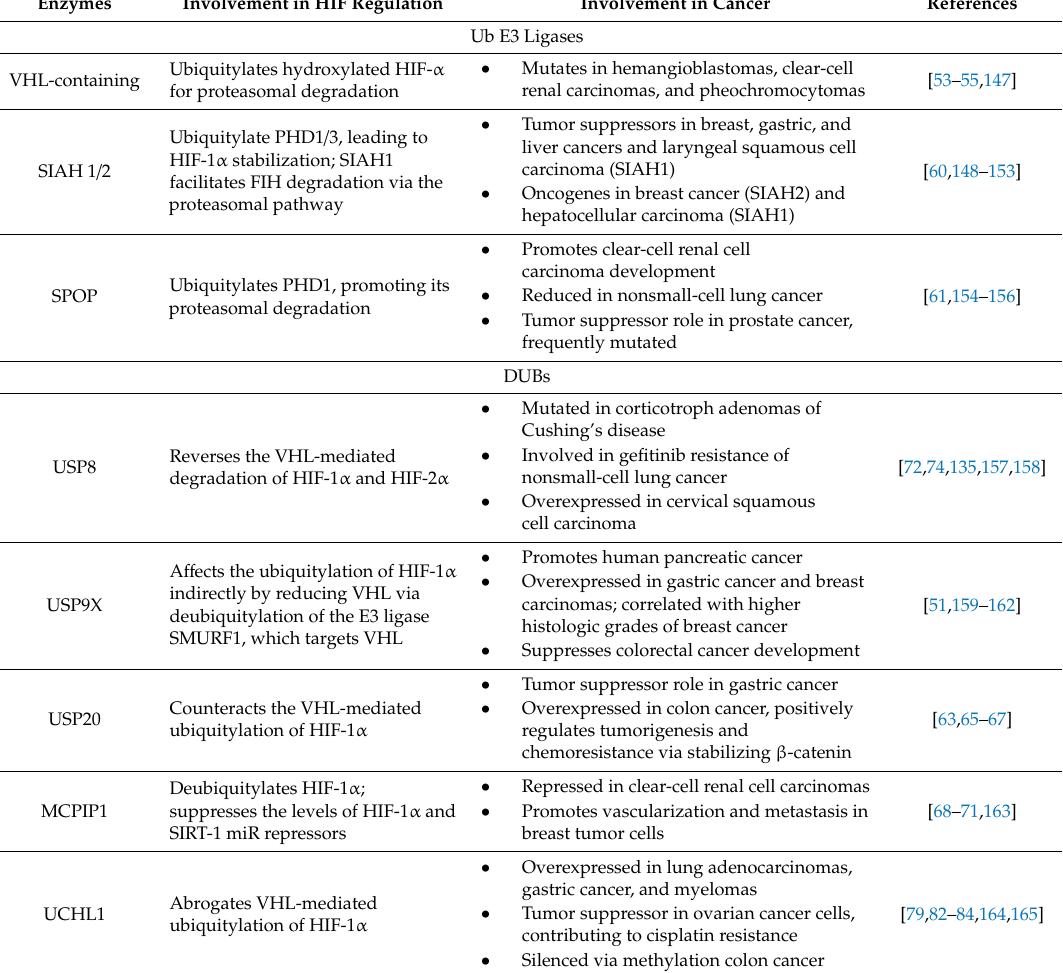
Table 1. E3 ligases and DUBs a ff ecting the oxygen-dependent regulation of HIFs and their involvement in